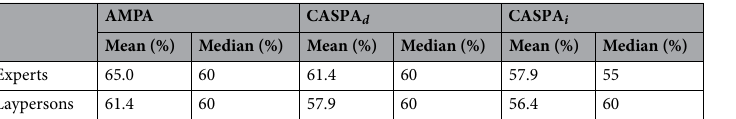
Table 5. Central tendencies of individual assessment accuracies for Hettich drawer assembly by participant